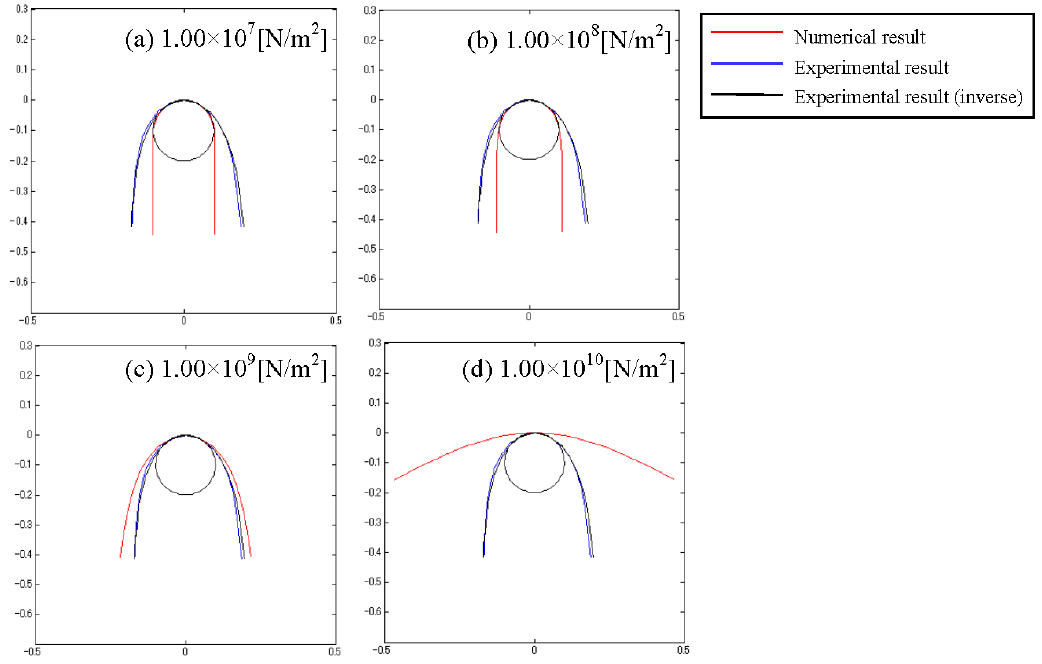
Figure 5. Results of numerical simulation and experiment when varying the bending elastic modulus.